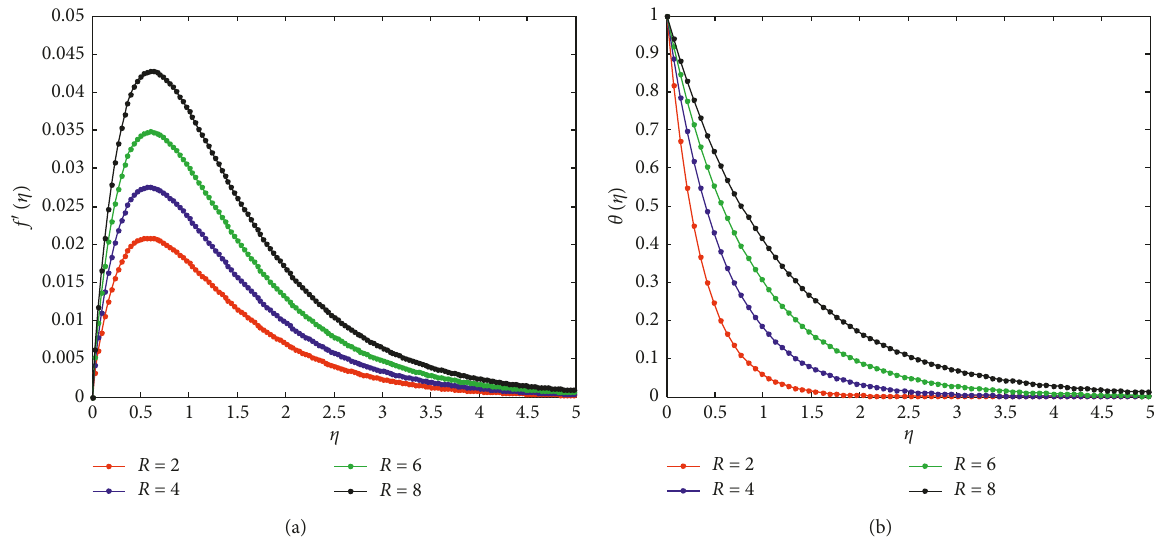
Figure 5: Effects of radiation parameter on the (a) velocity profile and (b) temperature profile of the Casson